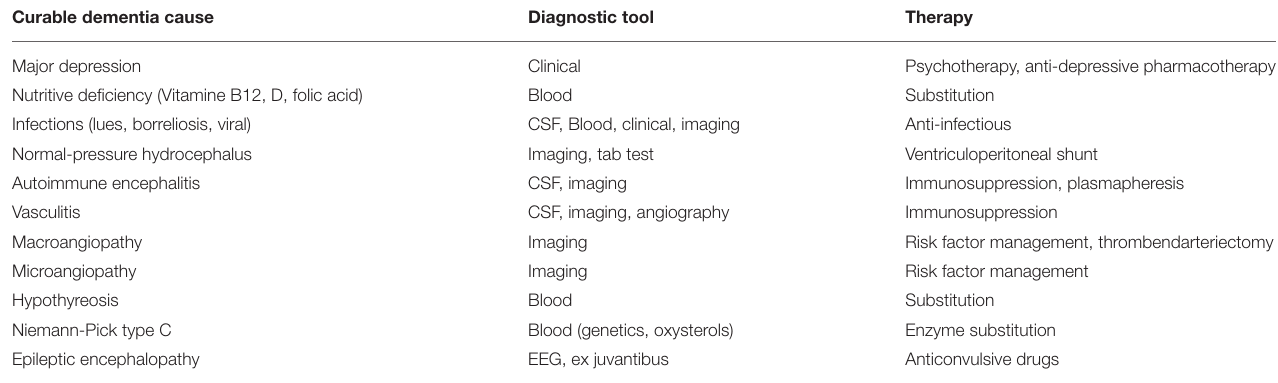
TABLE 2 | Potentially curable causes of dementia syndromes (Wallesch and Förstl, 2012; Day, 2019).